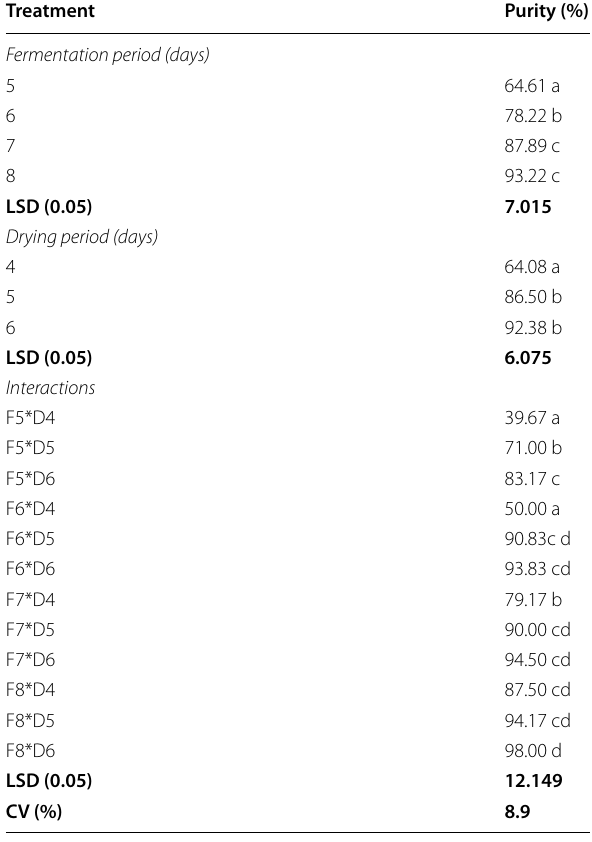
Bolding was done to differentiate the treatment means from the rest of the content of the table LSD, Least Significant Difference; CV, Coefficient of Variation Within column means with different letters differ significantly ( p